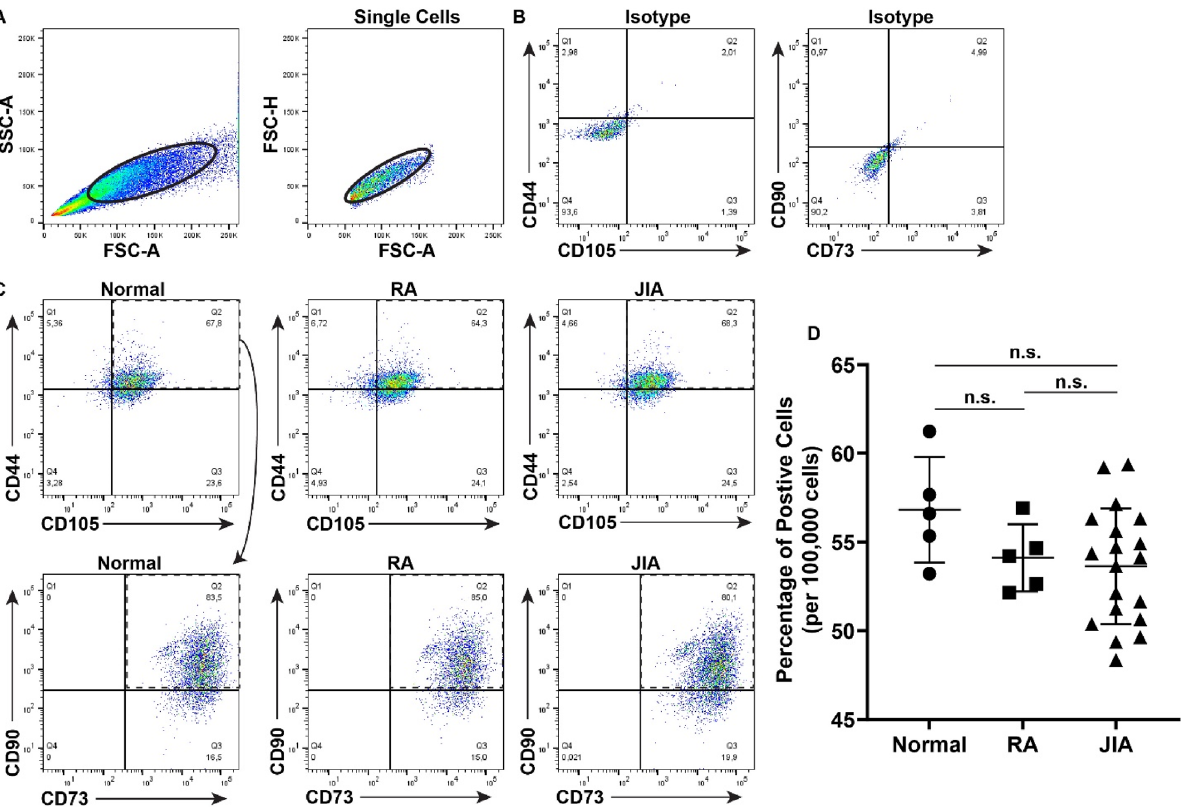
Figure 3. MPC abundance at P0 . Synovial MPCs from normal (n = 5), JIA (n = 19) and RA (n = 5) joints were purified using FACS at P0. Gates were designed for the non-debris and single cell populations ( A ). Isotype controls were used to developed thresholds for each marker ( B ). The cells positive for CD44 and CD105 were then examined for expression of CD90 and CD73 ( C ). These CD105, CD90, CD73, CD44 positive MPCs were then quantified in each group ( D ). n.s. = non-significant. Error bars represent mean + /-